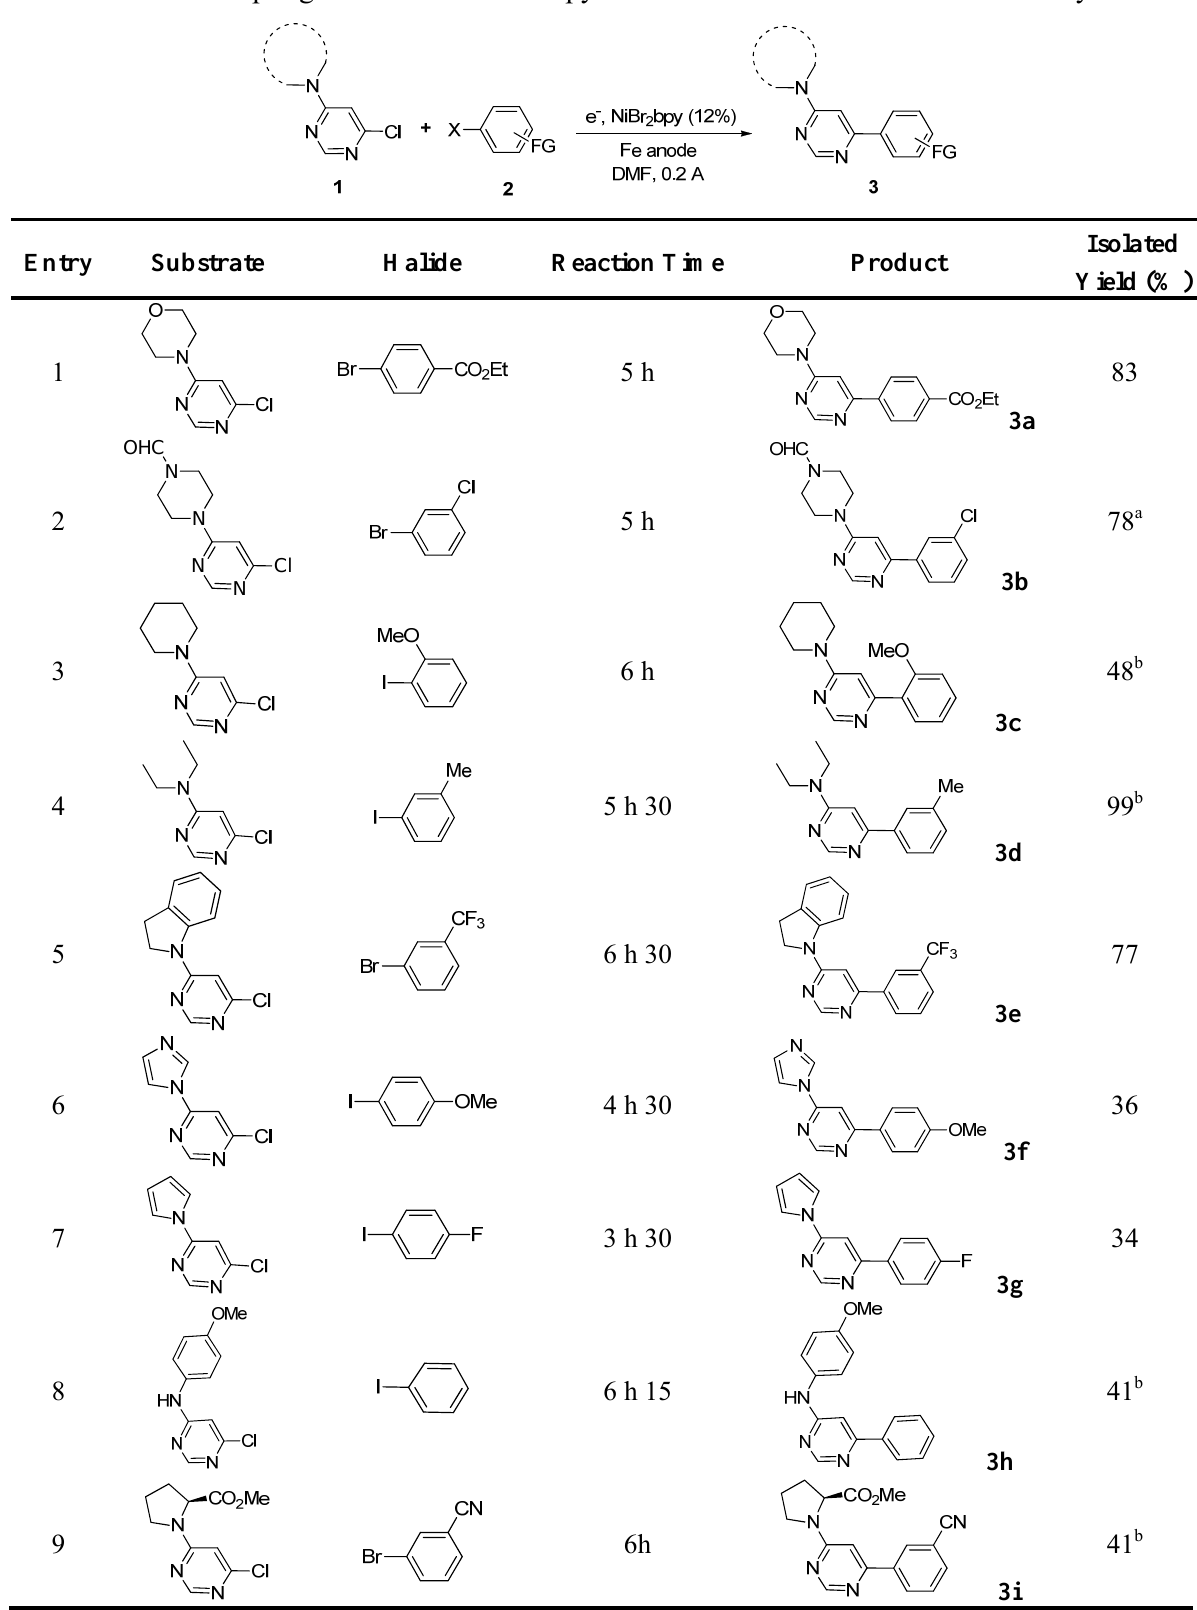
Table 1. Cross-coupling of 4-amino-6-chloropyrimidines with various functionalized aryl